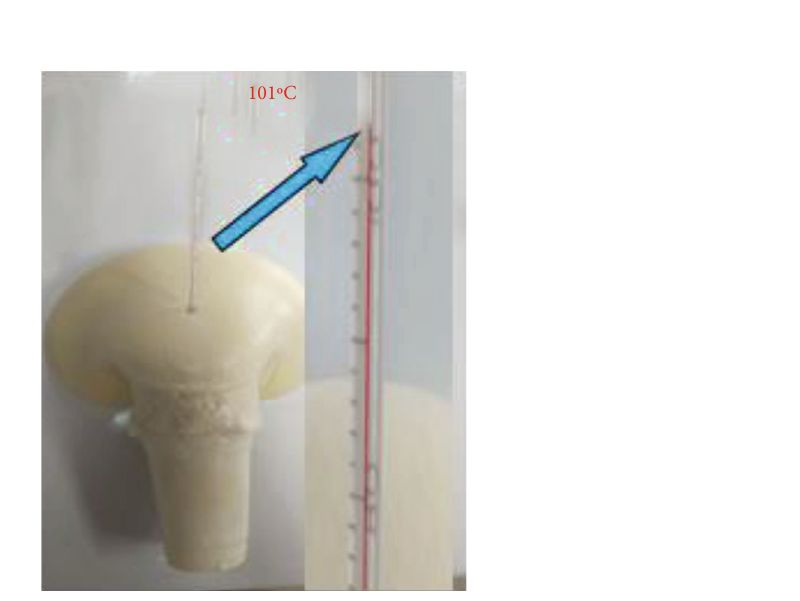
Figure 10: Temperature threshold of low exothermic polymer grouting material.